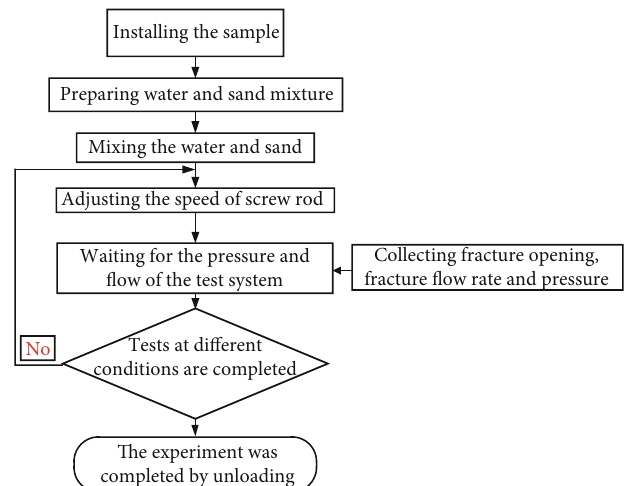
Figure 8: Experimental process of the seepage in rock fractures.